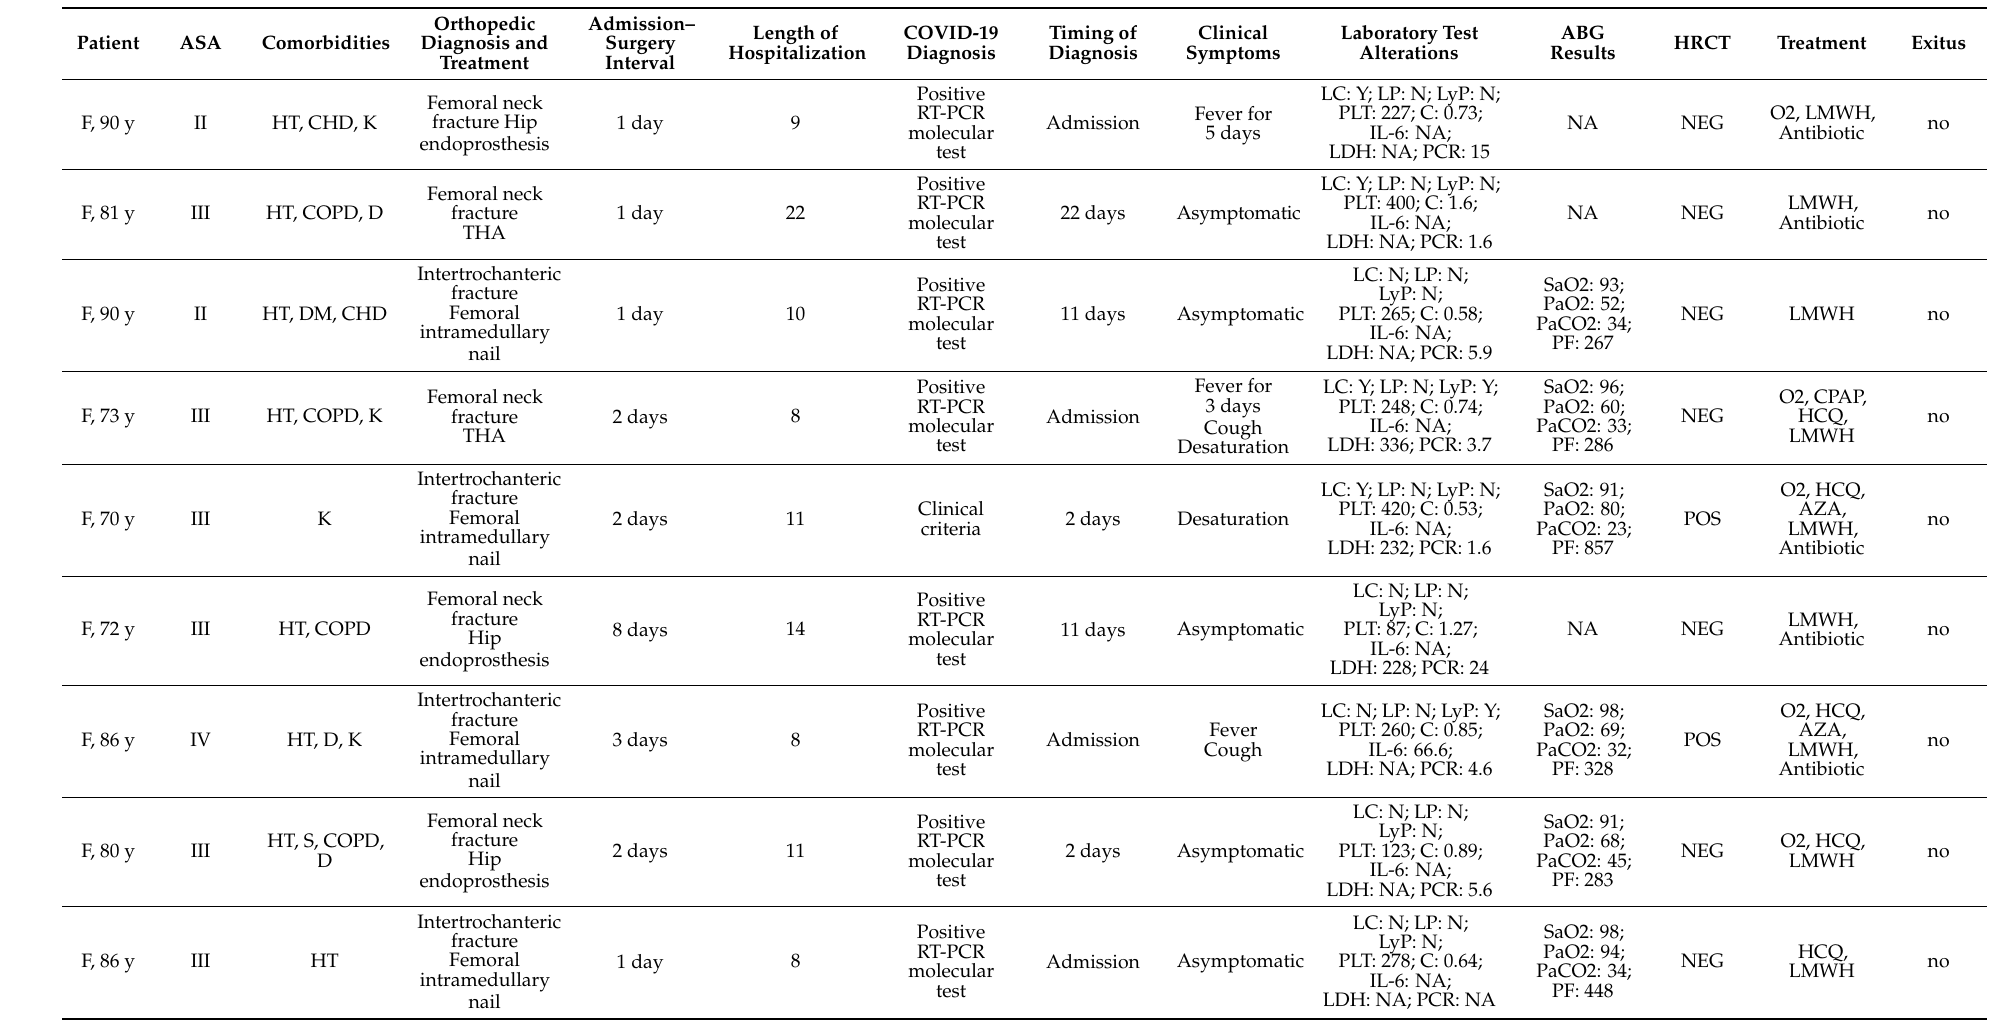
Table 3. Characteristics of COVID-19